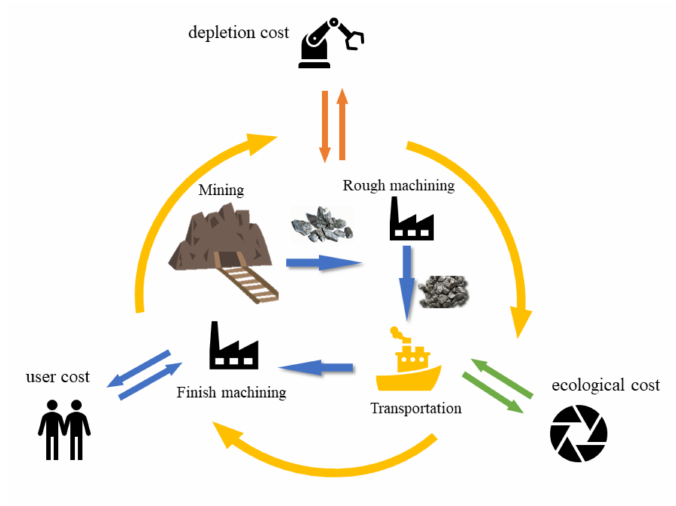
Figure 1. The policy instrument of the rare metal minerals exploitation